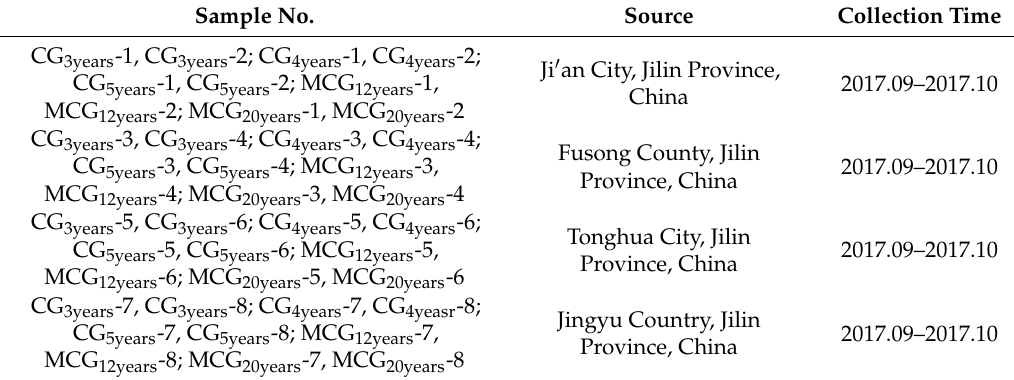
Table 1. Details of the MCG and CG samples. Sample